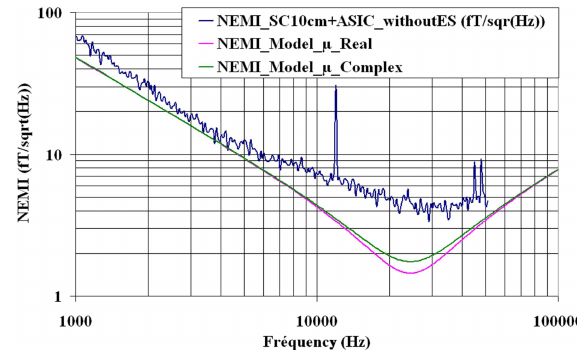
Figure 10. NEMI curves comparison: NEMI with real permeability (pink), NEMI with complex permeability (green) and NEMI mea- sured on a prototype